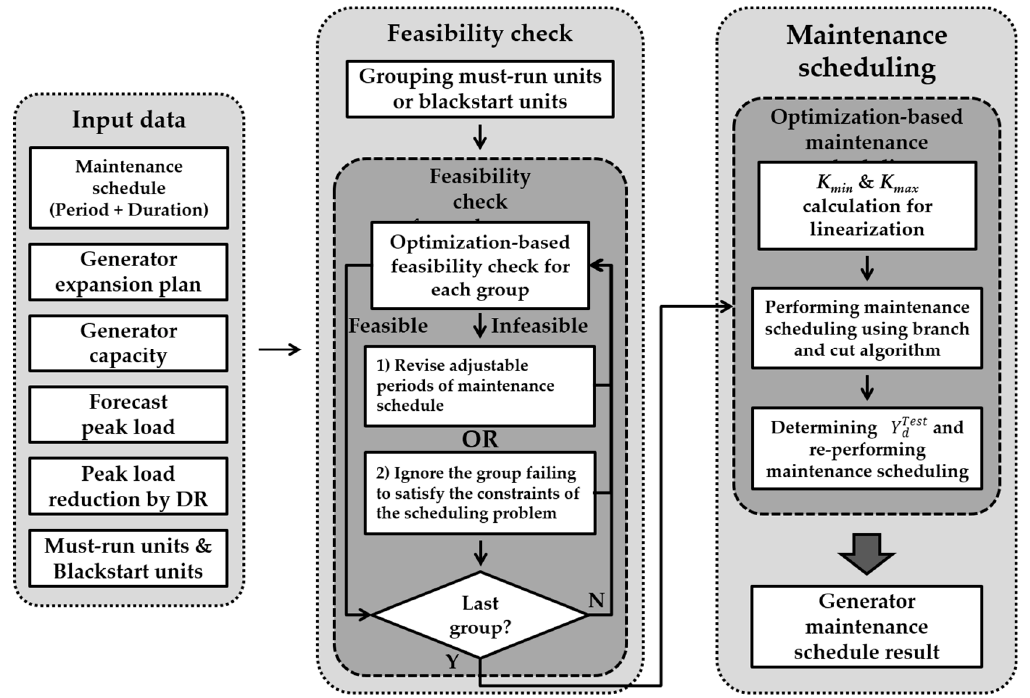
Figure 1. Flowchart of proposed generator maintenance scheduling (GMS) algorithm.